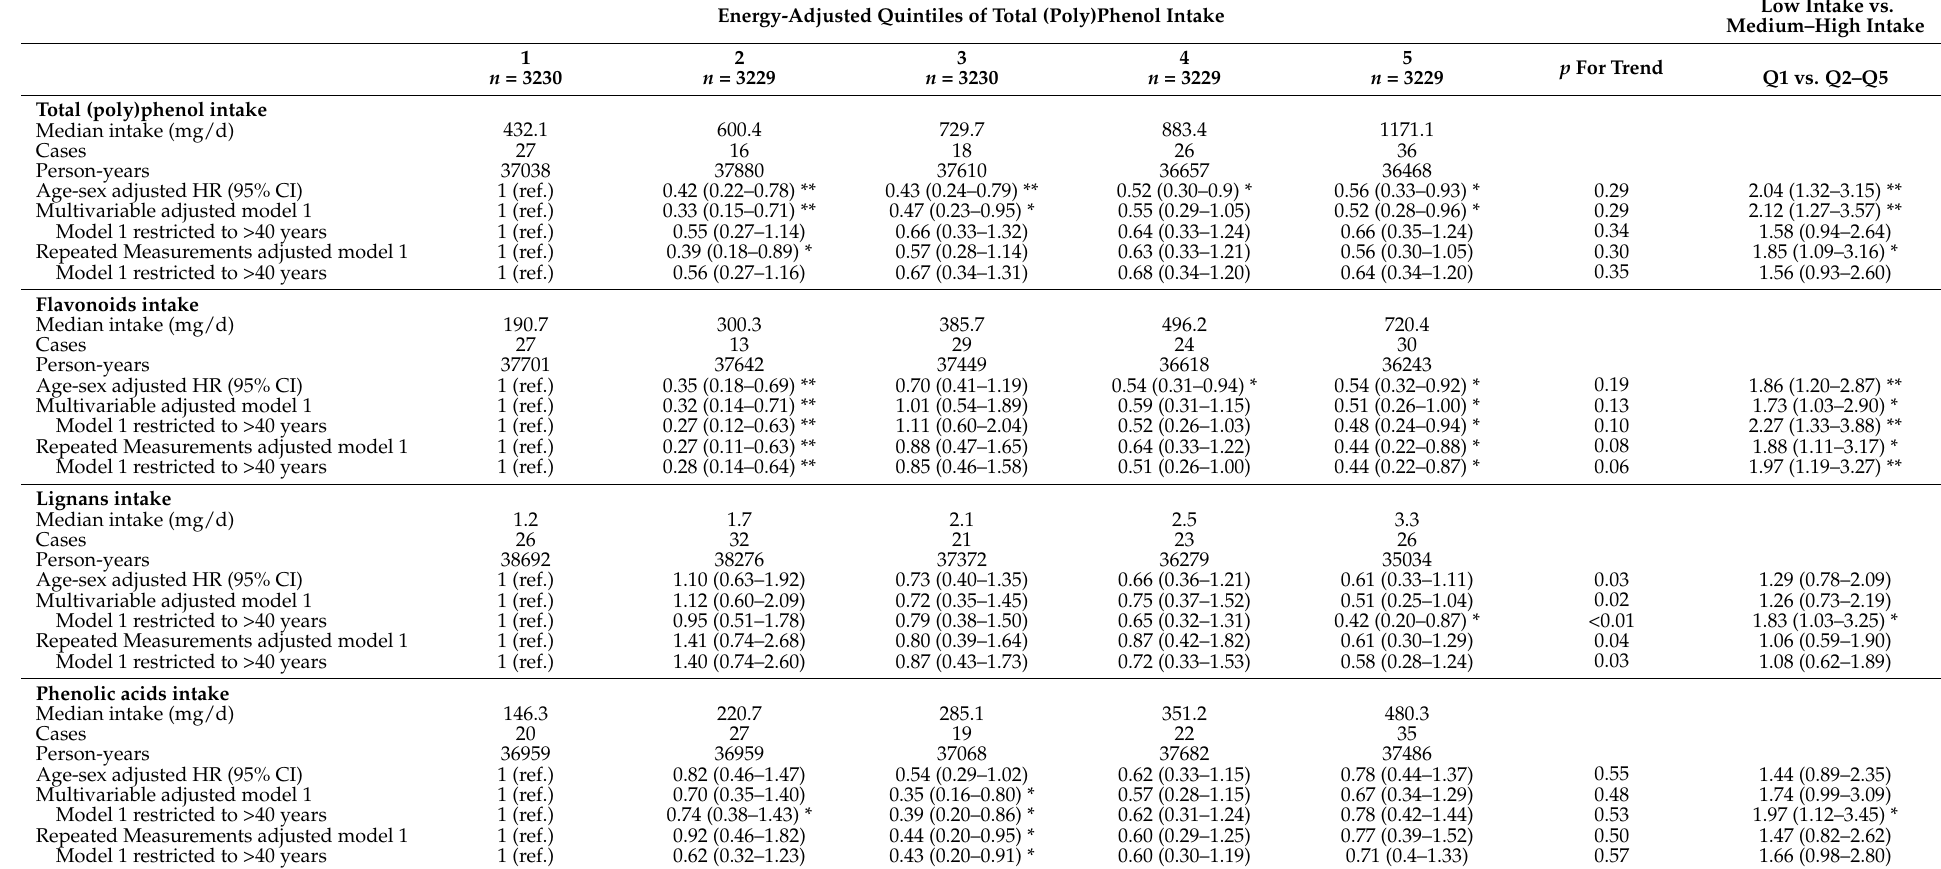
Table 3. Hazard ratio (HR) and 95% confidence intervals (CI) of confirmed cardiovascular disease cases according to quintiles of total (poly)phenol intake and (poly)phenol